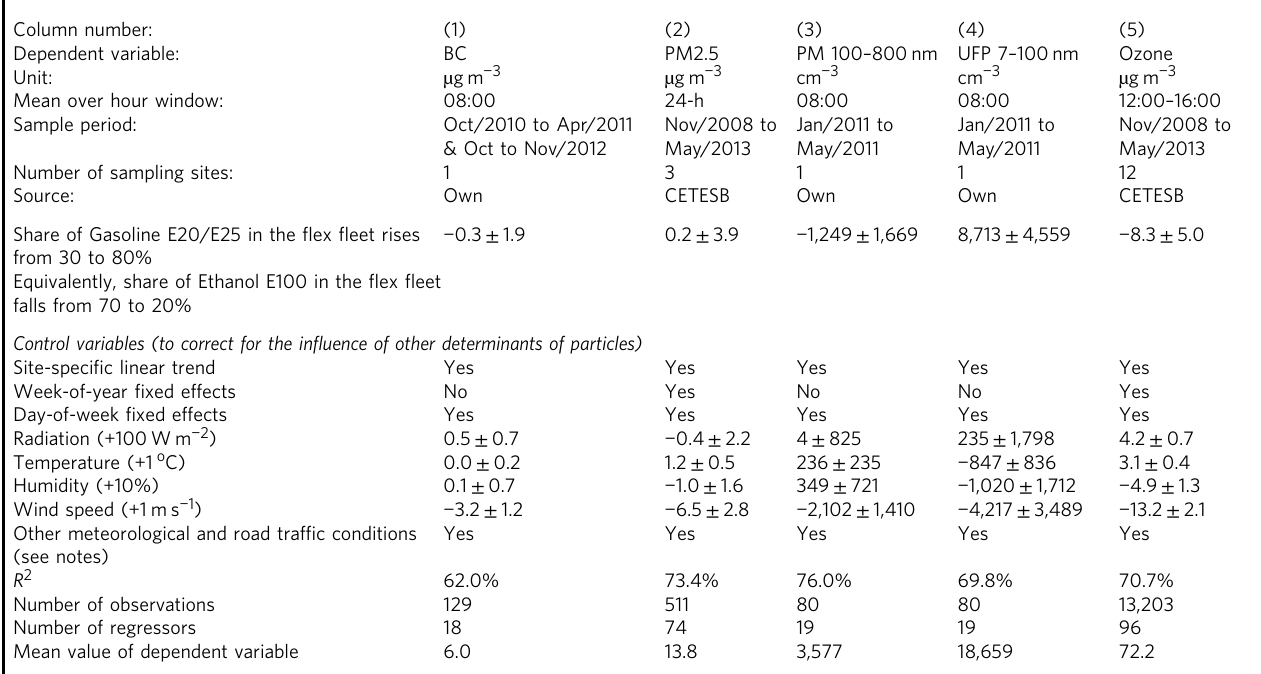
Table 2 Changes to particle and ozone concentrations associated with variation in the gasoline-ethanol fuel mix Column number: